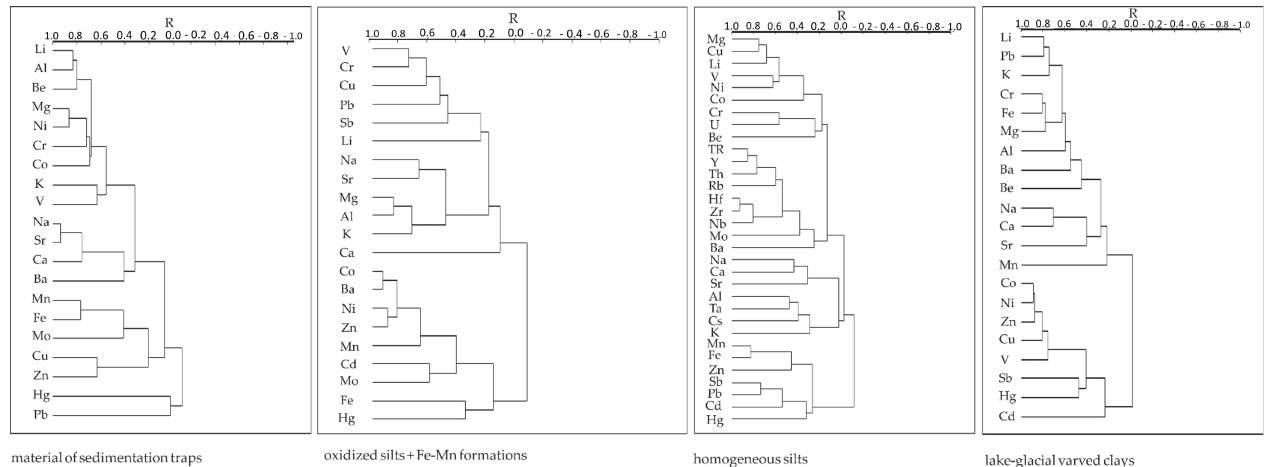
Figure 7. Dendrogram of the R-type cluster analysis calculated, based on the chemical element concentrations in the material of the sedimentation traps and the bottom